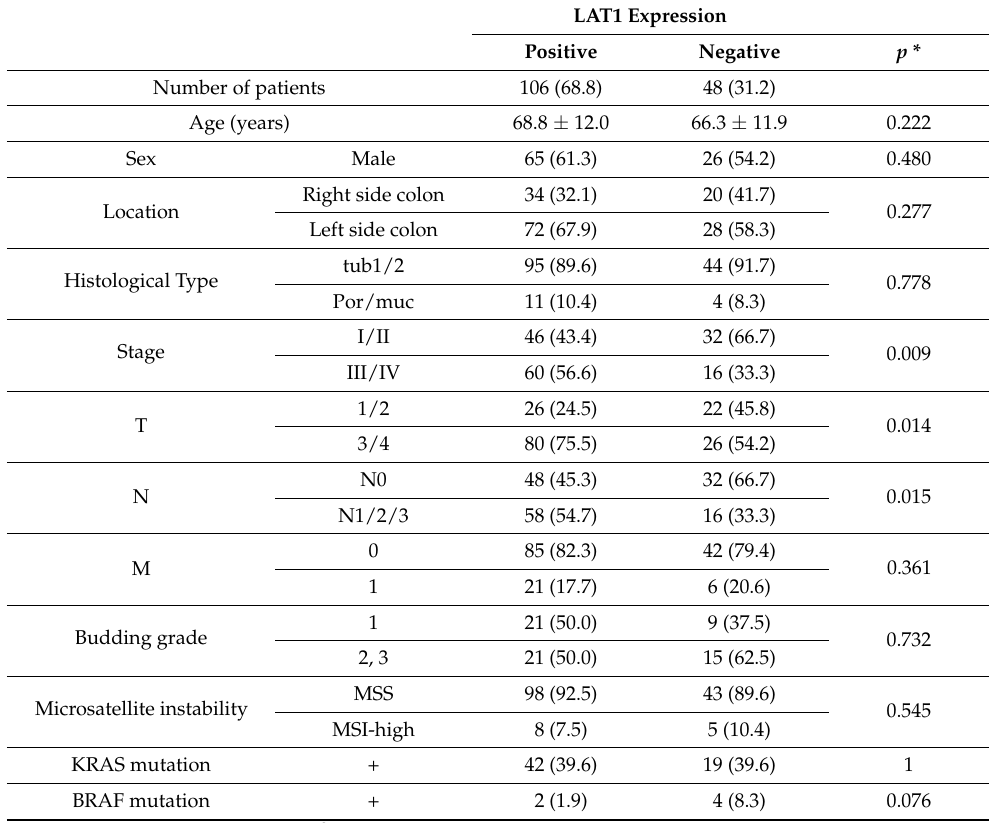
Table 1. Association between LAT1 expression and clinicopathological features of human colorec- tal cancers.